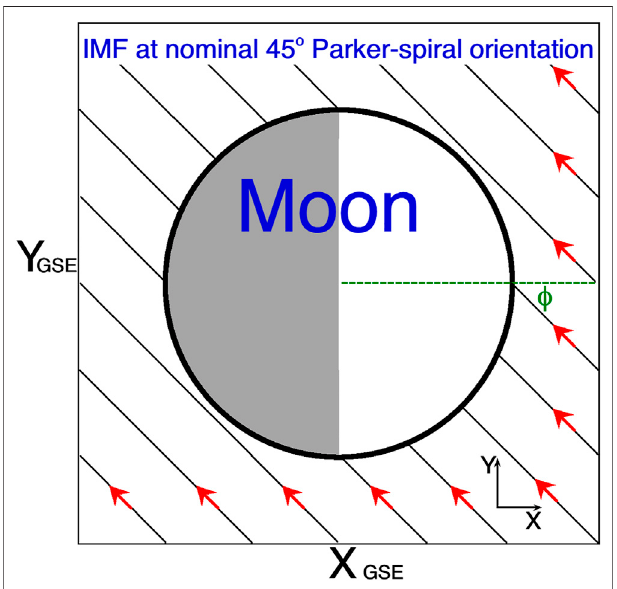
FIGURE 2 | A sketch of the Moon and its darkside (shaded) in the presence of a nominal θ (cid:1) 45 o Parker-spiral-oriented magnetic fi eld. The Sun- Moon line is indicated as the green dashed line.